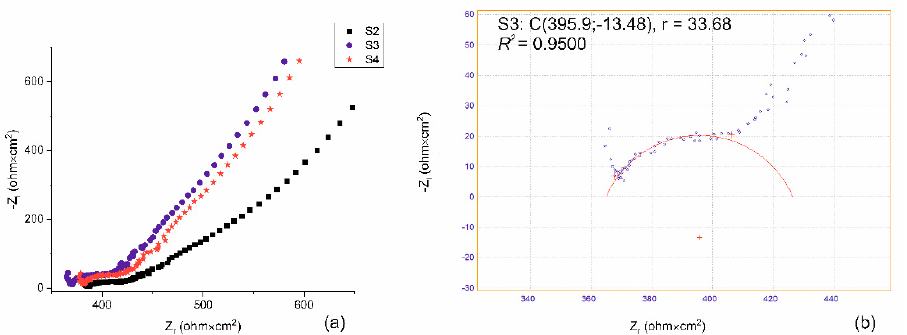
Figure 5. ( a ) The Nyquist plots for Pd/MWCNT in three concentrations (2100 ppm (S2), 5030 ppm (S3) and 9880 ppm (S4)). ( b ) The semicircle fit results for sample S3 (5030 ppm 2 H) are presented in the inset.